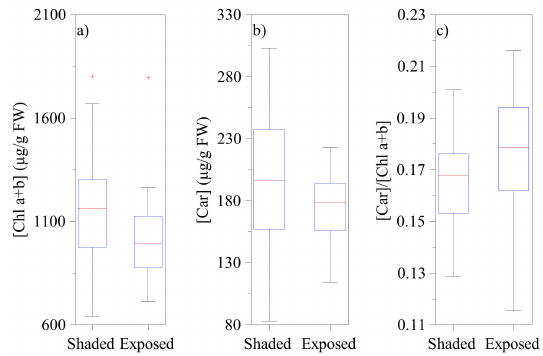
Figure 7. ( a ) Chlorophyll (Chl) and ( b ) total carotenoid (Car) concentrations; and ( c ) the pigment pool ratio [Car]/[Chl] for the two needle classes in